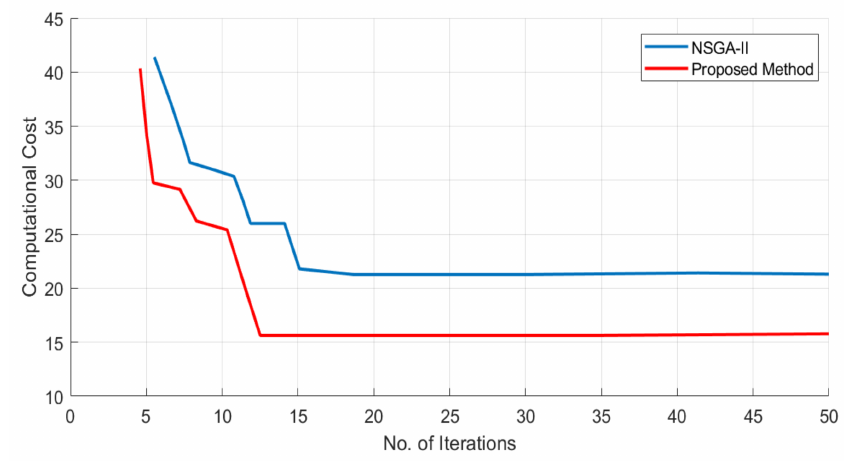
Figure 6. Performance comparison between the proposed method and the NSGA-II; the y -axis represents the computational cost, and the x -axis shows the number of iterations.